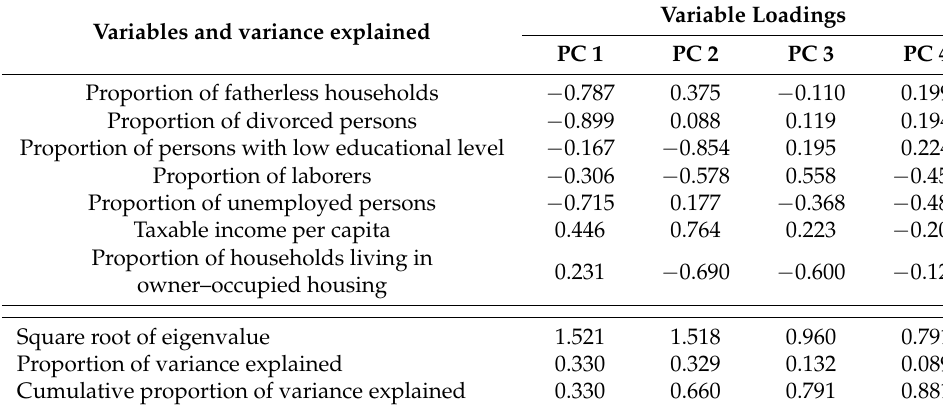
Table 3. Result of the principal component analysis. (Up to the PC